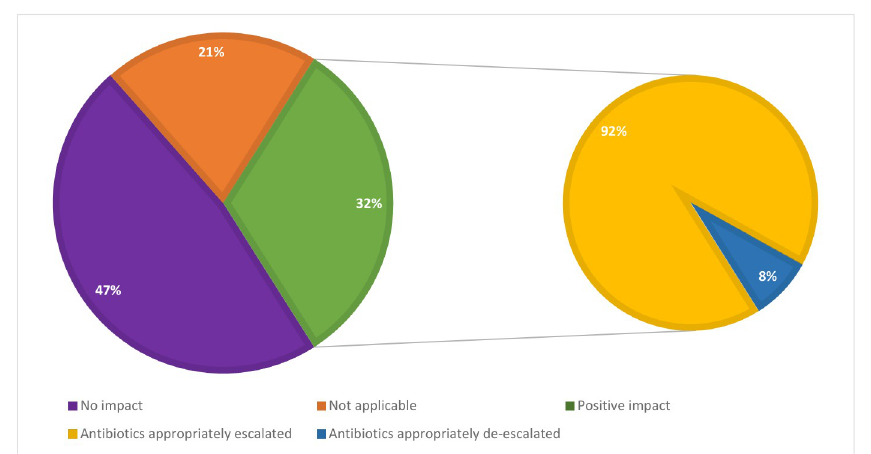
Fig 1. Impact of the BioFire FilmArray BCID panel on the adjustment of antimicrobial therapy.